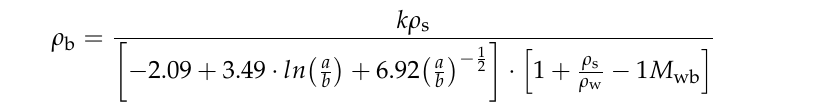
19 of 41 Figure 7. Bulk porosities in various legume ( a < b ) (digitized from [132] ) and grain kernel ( a > b ) (digitized from [130] ) packings as a function of legume or kernel aspect ratio. Modeled porosities are shown for a range of scaling coefficients, k, using Equations (19) and (20). 2.2.3. The Grain Bulk Density